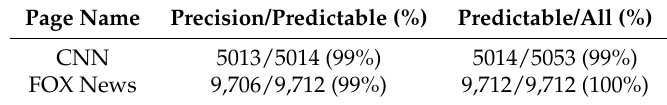
Table 4. Bandwagon effect cross validation—non-target to target, observed time = 120